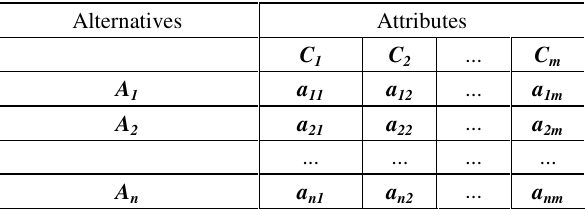
Fig. 4. Decision-making matrix for multi-attribute deci- sion-making